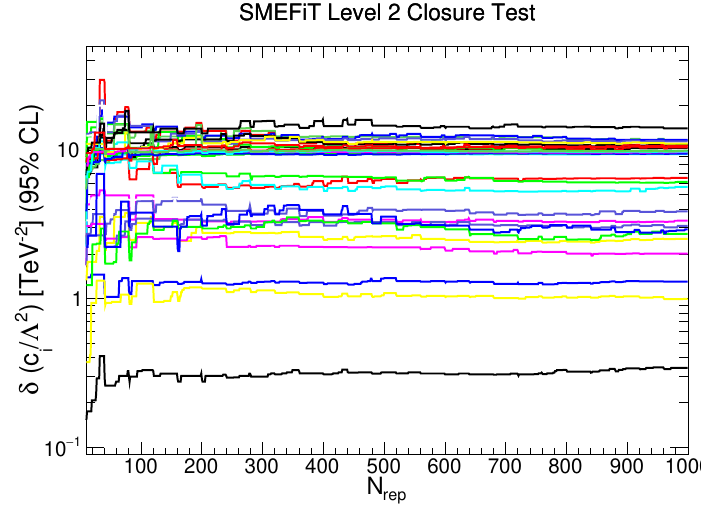
2 with the number i = (cid:3)